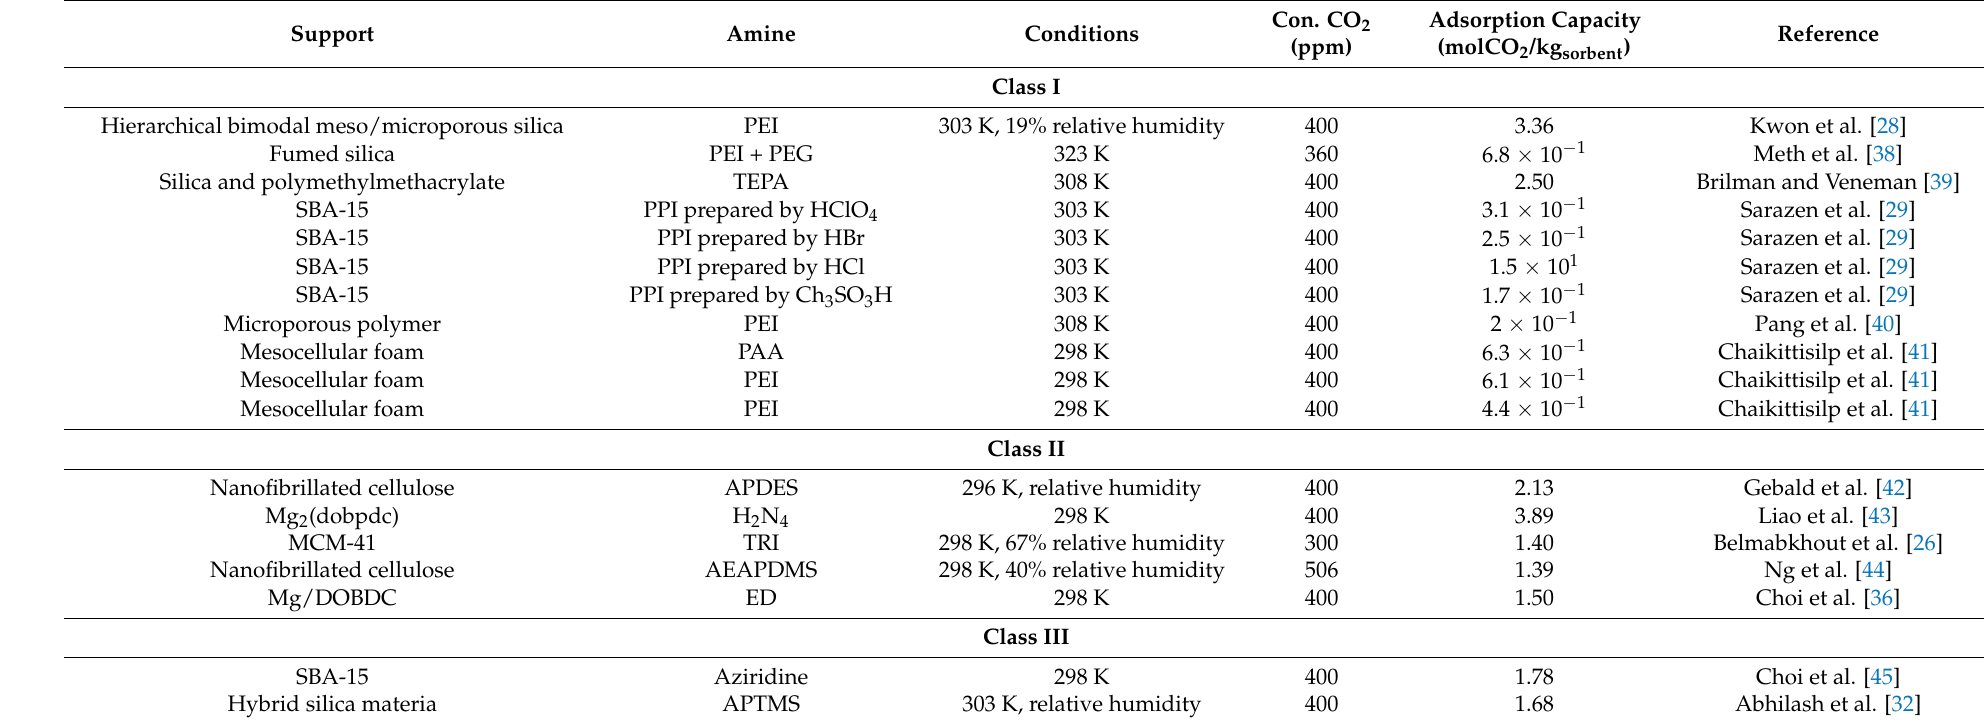
Table 1. CO 2 uptakes of some amine-functionalized